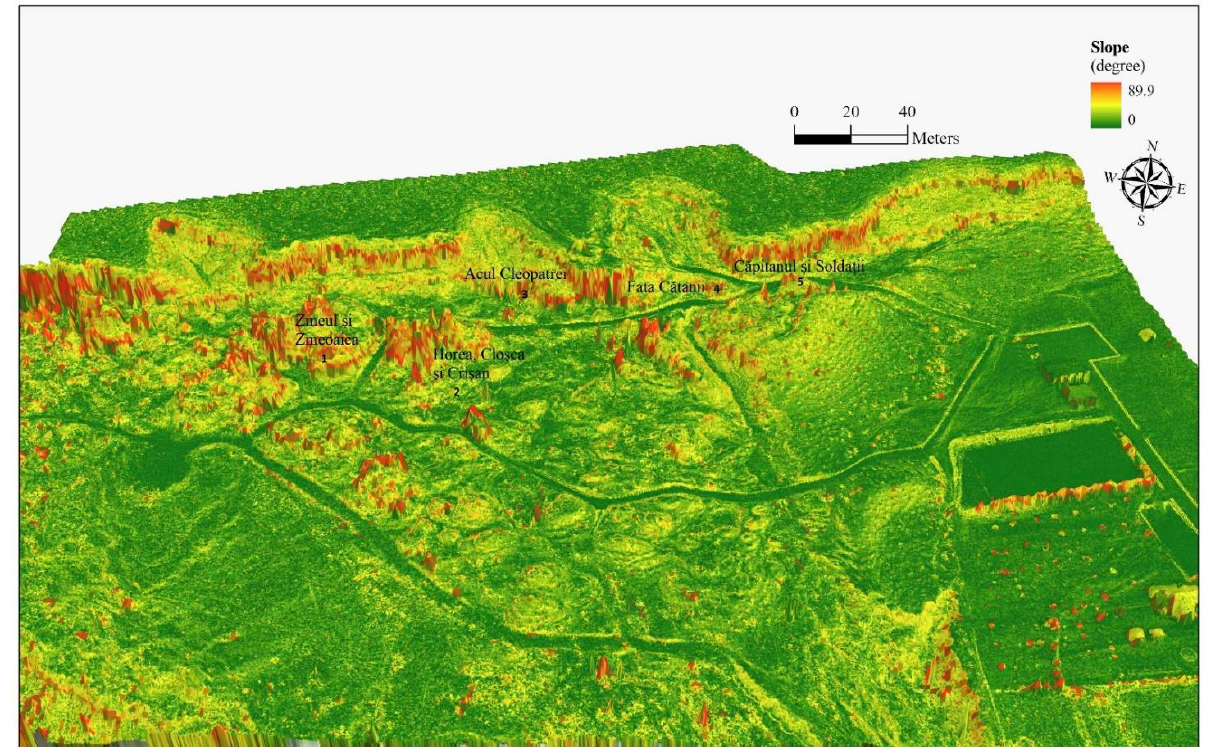
Figure 5. Slope Map of the Grădina Zmeilor geomorphosite (where: 1 — Zmeul and Zmeoaica, 2 — Horea, Cloșca and Crișan, 3— Acul Cleopatrei, 4 —Fata Cătanei, 5—Căpitanul and Soldații) .